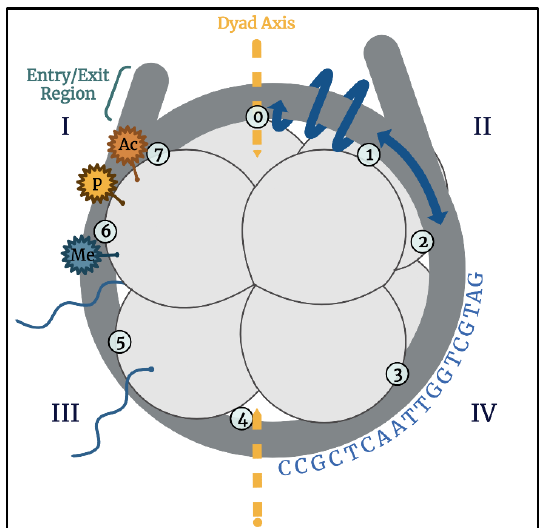
Figure 2. Representation of a nucleosome core particle (NCP) showing the histone core (light gray) and DNA (dark gray). The dyad axis, entry/exit regions, and seven SHLs (circles numbered 1 – 7) are labeled. For simplicity, the NCP is divided into four quadrants to depict factors that will be discussed in this review: post translational modifications (region I), rotational and translational nucleobase positioning (region II, blue arrows), unstructured N-terminal histone tails (region III), and DNA-sequence-dependent factors (region IV). Image created using BioRender.